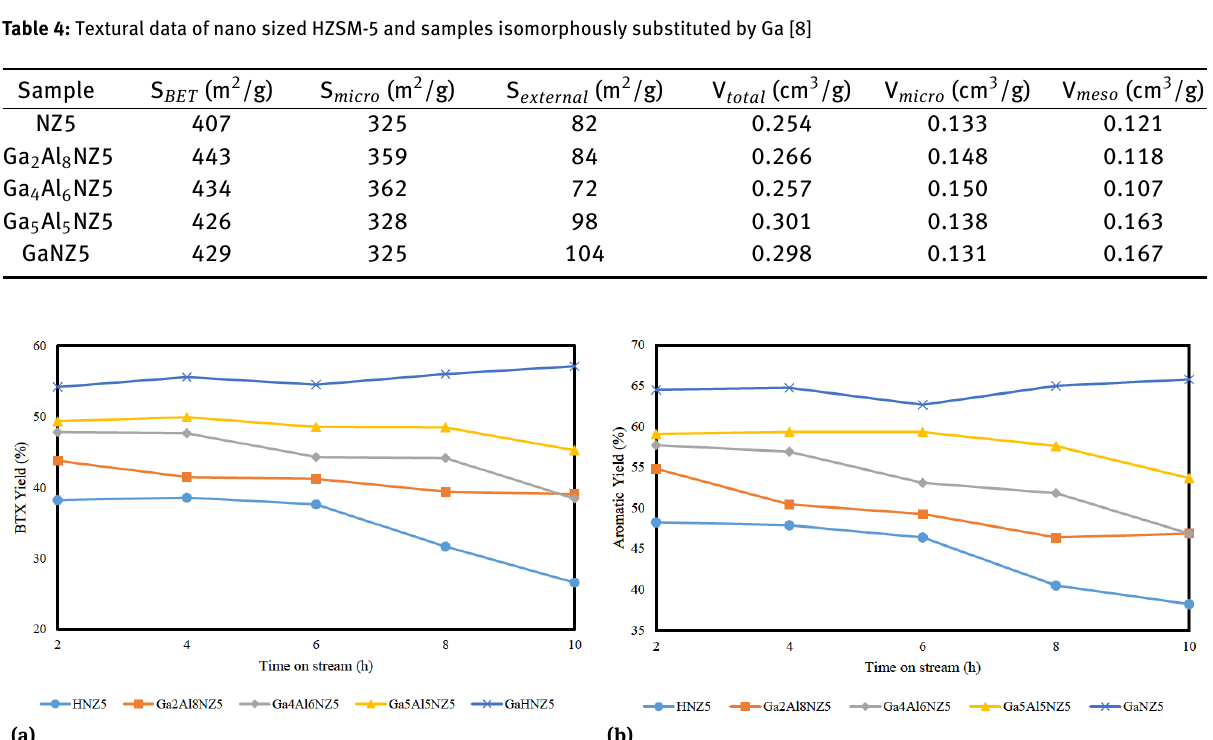
Figure 4: BTX yield (a) and aromatics yield (b) of 1-hexene aromatization over the nanosized HZSM-5 and samples isomorphously substi- tuted by Ga